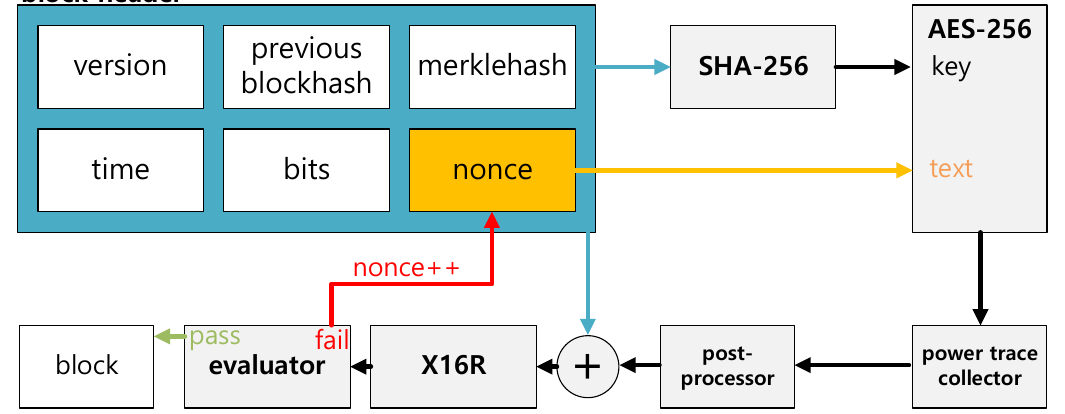
Figure 1. Working flow of proposed Proof-of-Work